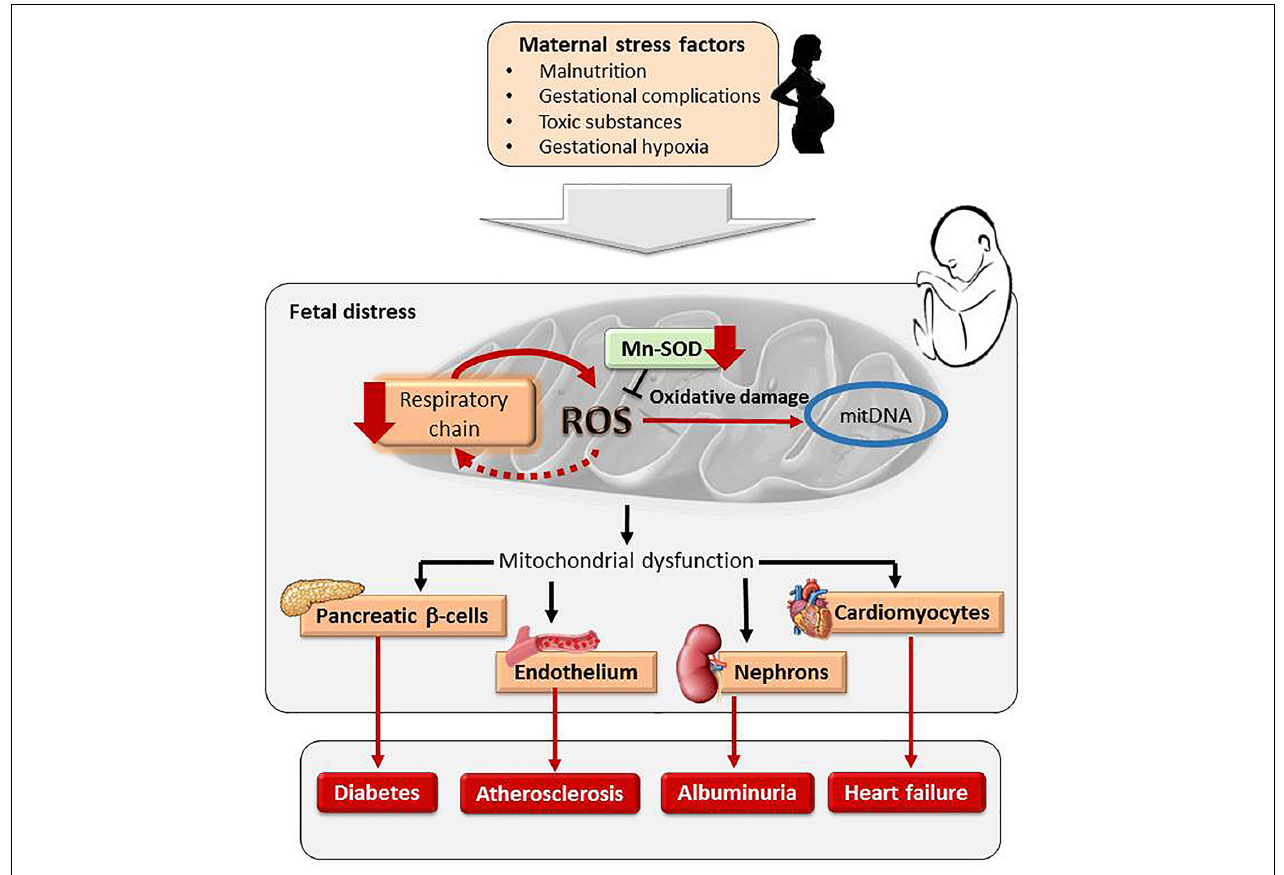
FIGURE 3 | Maternal exposure to stress factors during pregnancy programs fetal mitochondria. An increase in ROS, respiratory chain inhibition and a vicious circle of ROS-induced ROS release and a reduction of mitochondrial antioxidant system MnSOD damages mitDNA. Mitochondrial programming in response to intrauterine stress factors has been found in pancreatic β -cells, cardiomyocytes, vascular endothelium and nephrons, contributing to cardiometabolic